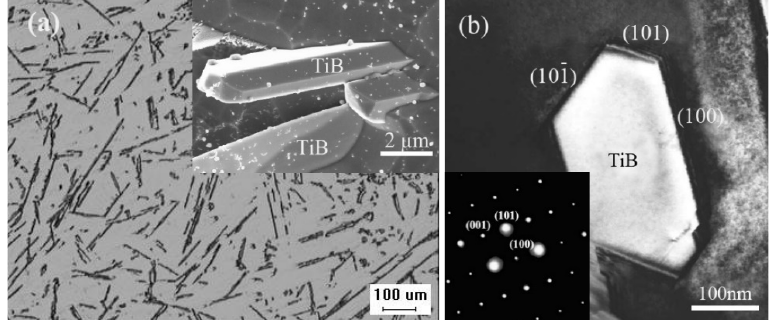
Figure 3. ( a ) Optical morphology and scanning electron microscopy images of the in situ TiB fibers. ( b ) Transmission electron microscopy (TEM) and selected area diffraction patterns of in situ TiB fibers in the as-cast composite.